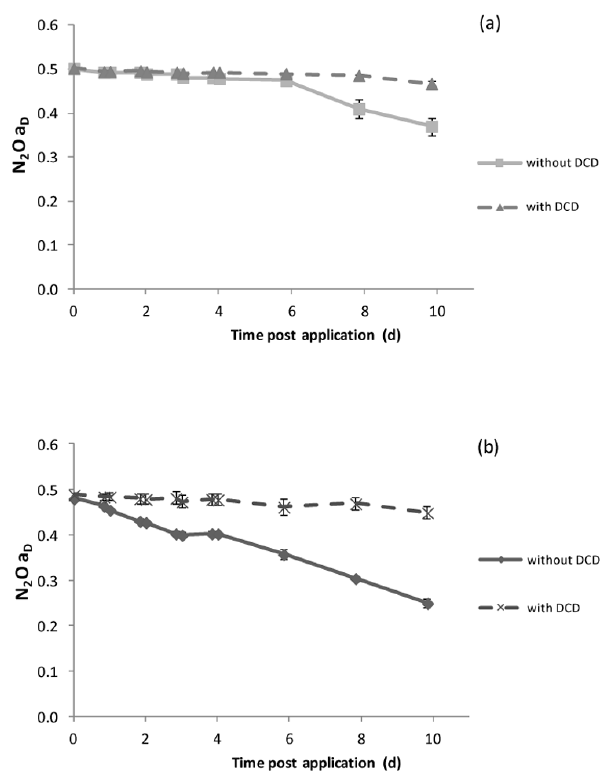
Fig. 4. Change in the 15 N mole fraction of the labelled nitrate pool ( a D ) over time in March 2009 for 14 CS 15 NO 3 (a) and for 14 NH 15 NO 4 Cl 3 (b) with and without DCD. Error bars indicate standard